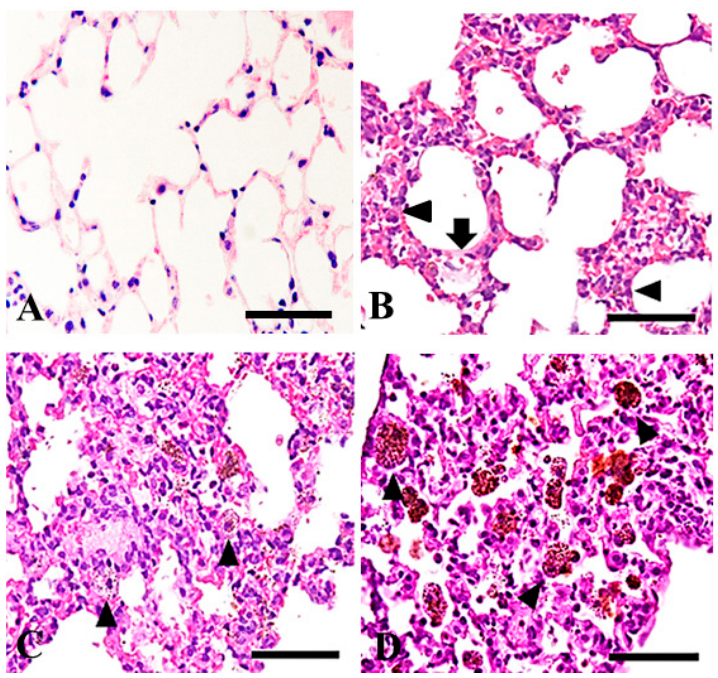
Figure 3. Higher power magnification of the histological findings of the control lungs ( A ); of mice treated with 50 mg/m 3 of the powder for one day ( B ); treated for 15 days ( C ); of mice treated with 200 mg/m 3 of the powder for 15 days ( D ). Infiltration of neutrophils into alveoli and increased number of macrophages (black arrowheads), and exudation of serum protein in the alveolar space (black arrow) ( B ). Macrophages with increased cytoplasm containing the particles are shown (black arrow heads) ( C , D ). HE. Bars = 50 µm.